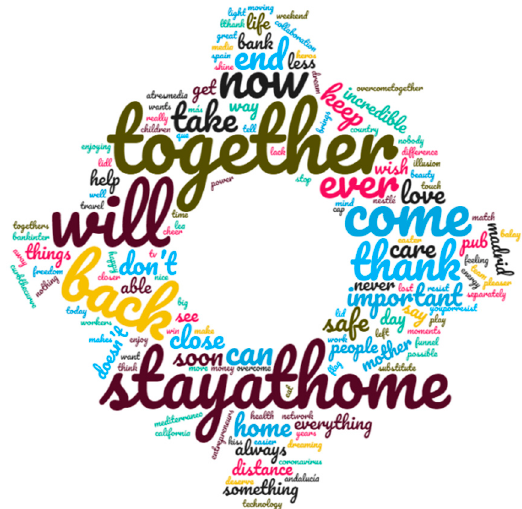
Figure 7. Word cloud of slogans.